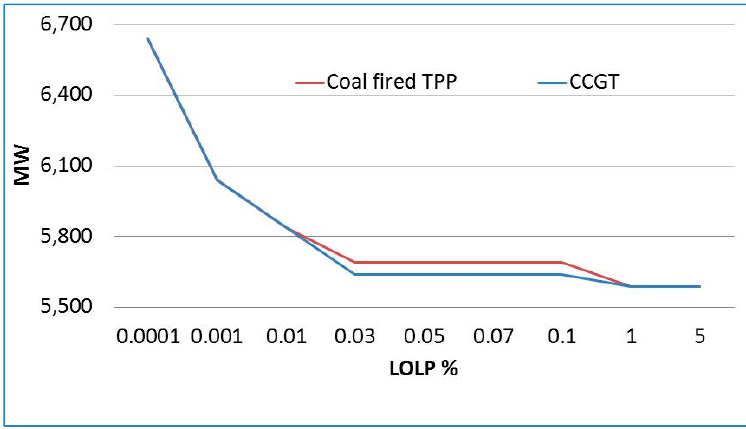
Figure 2. Necessary construction of new capacities to meet loss of load probability (LOLP).